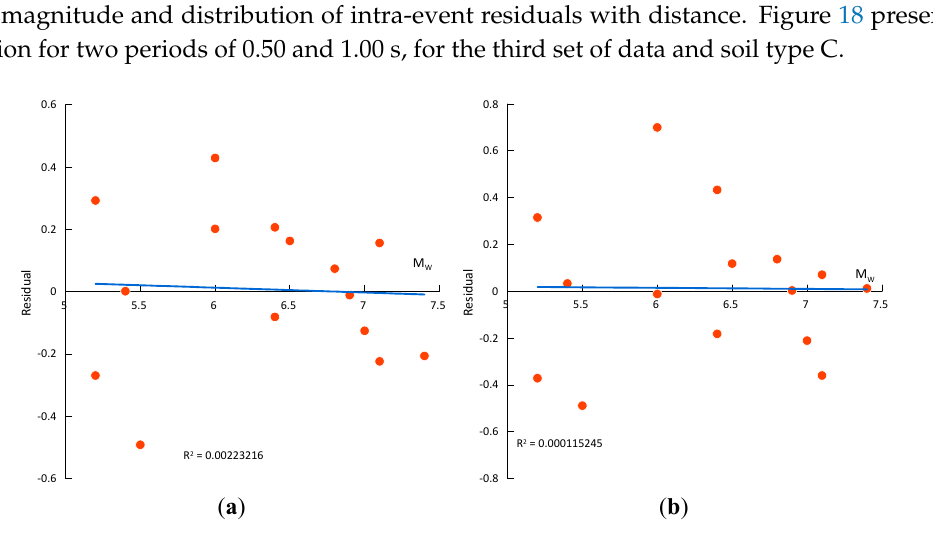
Figure 18. Inter-event residuals dependence on magnitude, set 3. ( a ) T = 0.50 s; ( b ) T = 1.00 s.